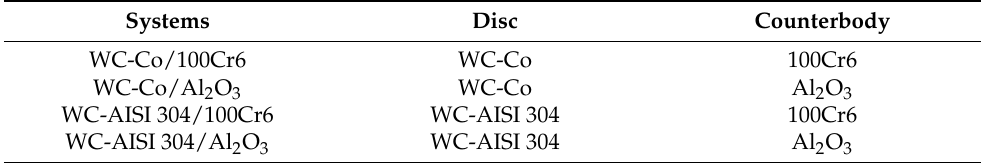
Table 2. Identification of the tribological systems under study.